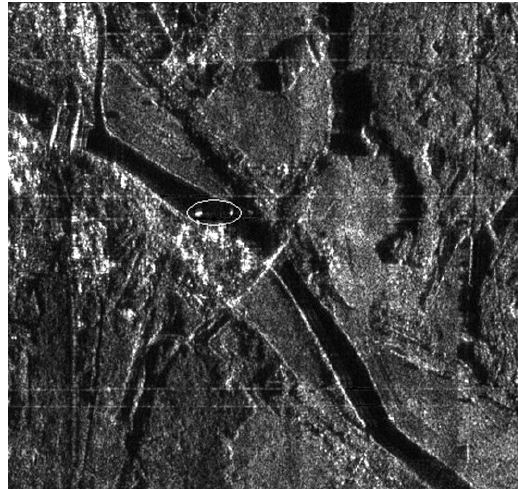
Figure 2. Small-scale blob-like objects to be extracted